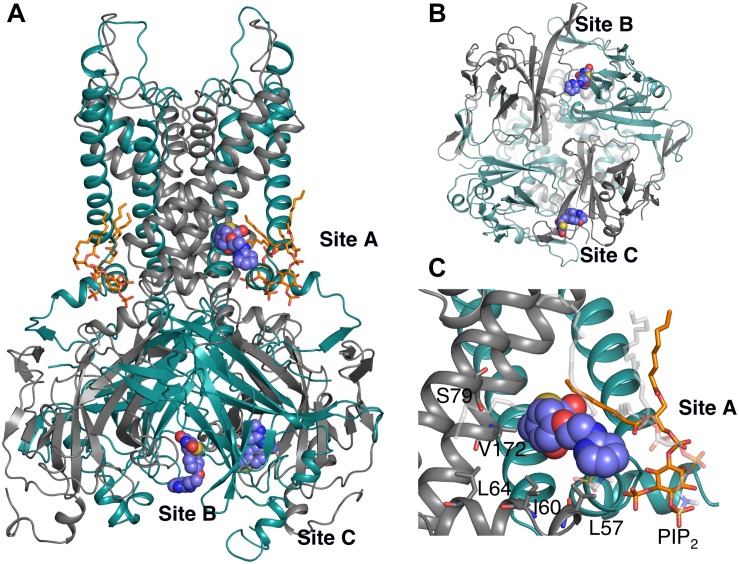
Three binding sites observed after 1.5 μs unbiased MD simulation. The protein is represented as cartoon; adjacent subunits are colored in green and gray, respectively. PIP2 molecules are shown as orange sticks. Ligands are represented as purple spheres. (A) Side view of the whole protein highlighting the three ligands bound to binding sites A – C. Site A: in close proximity to the PIP2 binding site; Site B: at the interface between 2 CTDs; and Site C: between the β-sheet βD and the βG-αG loop. (B) Bottom view of Site B and Site C. (C) Detail view of site A: residues within 6 Å of the ligand are labeled and presented as gray sticks. The ligand mainly forms hydrophobic interaction with LEU57 and ILE60; additionally, it forms hydrophobic and hydrogen bond (HB) interactions with lipid molecules (transparent sticks in light gray).